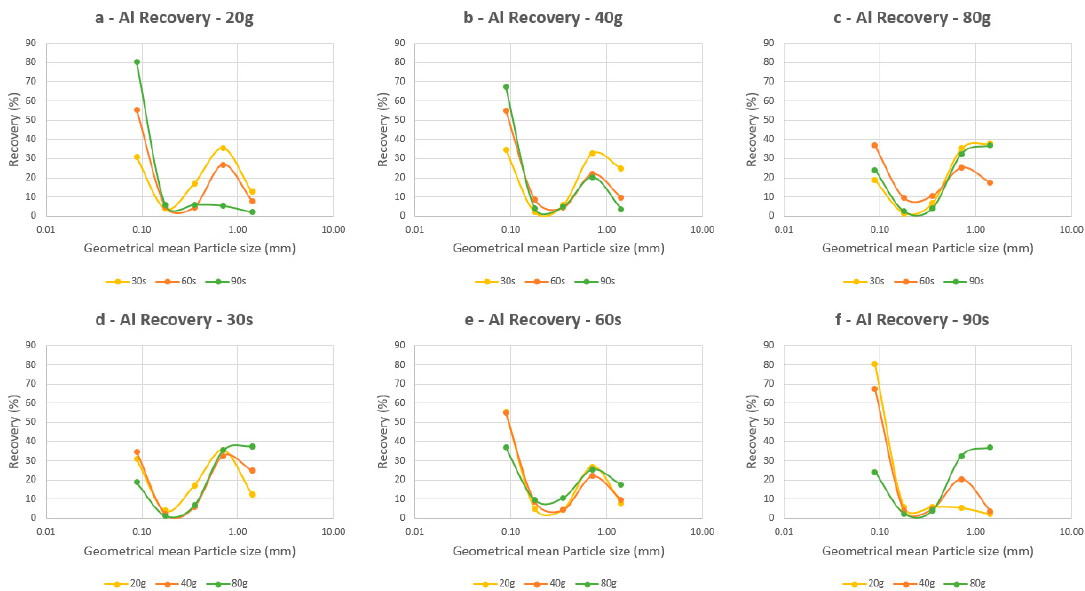
Figure 6. Al recovery after hammer milling as a function of feed mass, milling time and particle size. Feed Size 1–2 mm ( a ) 20 g feed, ( b ) 40 g feed ( c ) 80 g feed, ( d ) 30 s milling time, ( e ) 60 s milling time, and ( f ) 90 s milling time. Experimental data points are connected with lines for the purpose of visual aid only.